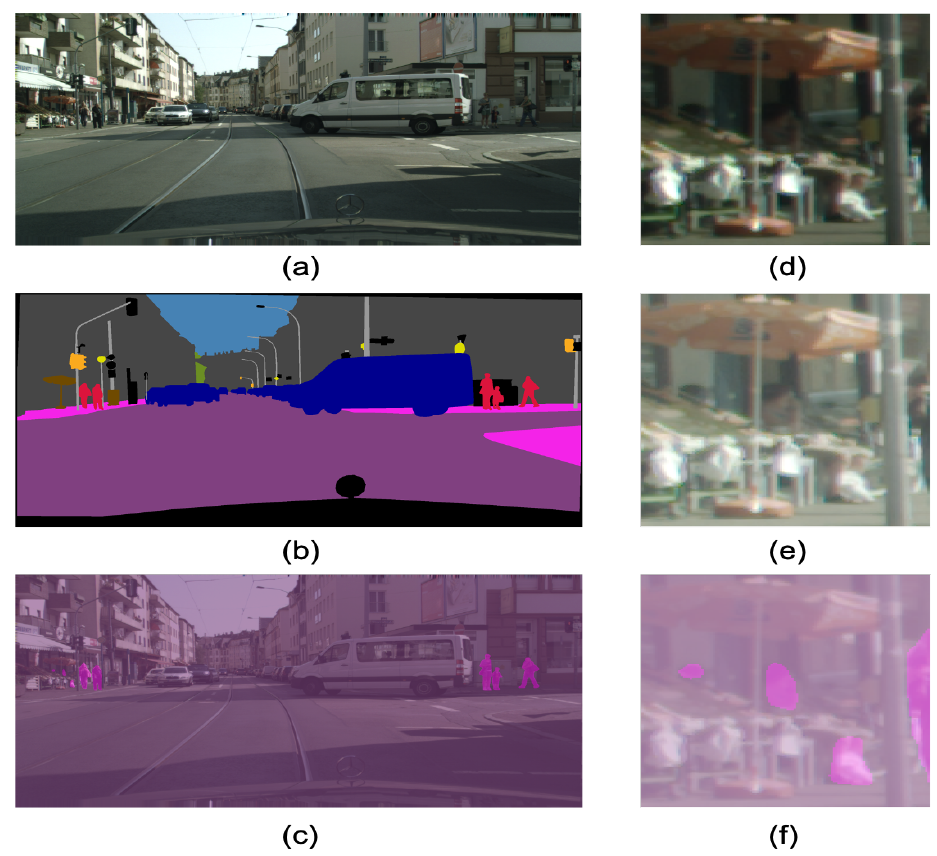
Figure 6. Important case where the ground truth does not contain a specific instance of human